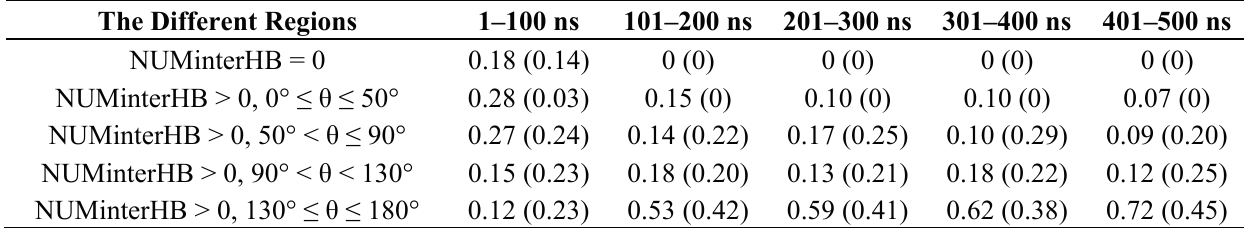
Table 5. The respective probabilities for the α -syn12 dimer fall within different inter-backbone hydrogen bonds at the different pH and simulation time. The results at the acidic pH are shown in the